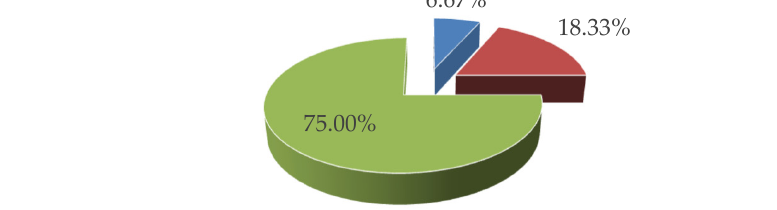
Figure 4. Distribution and characteristics of hypopharyngeal and parapharyngeal lesions that required surgical therapeutic management.